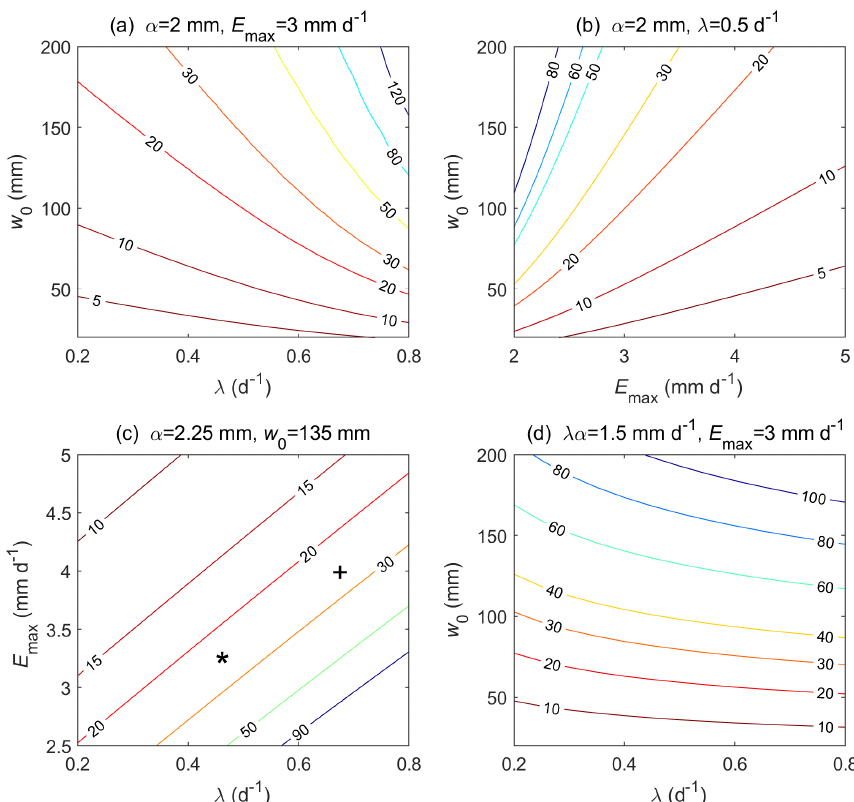
Figure 3. The influence of hydrometeorological factors on the mean first passage time (days) of soil moisture dropping from the 40th to the 20th percentile. w 0 is water storage capacity in the root zone, λ is rainfall rate, α is average rainfall depth, and E max is potential evapotranspiration. The plus sign and asterisk ( + and ∗ ) correspond to the sites in Guangdong, China, and New York state, USA, for the values of hydrometeorological factors and MFPT, respectively (see Fig.